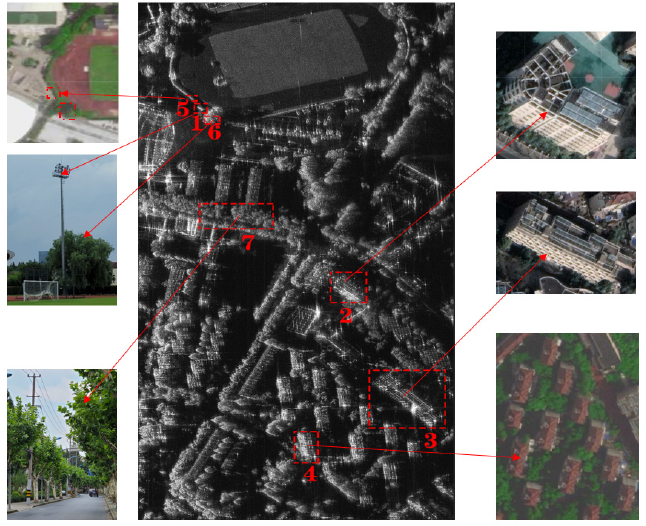
Figure 10. Selected targets and their optical images.